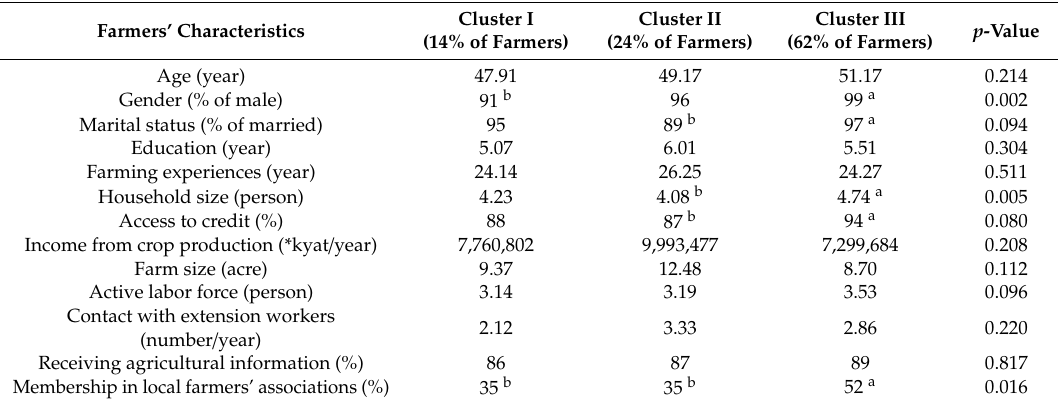
Figure 3. Dendrogram of farmers’ awareness of low yield of conventional rice production. Source: Author. Table 7. Comparison of farmer characteristics among three